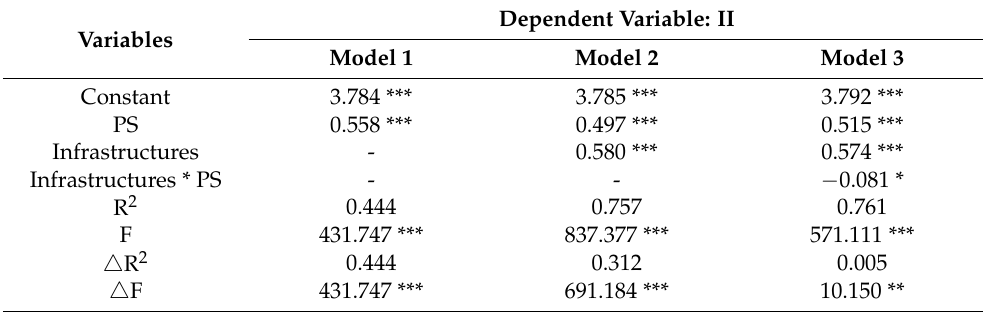
Table 8. Hierarchical regression analysis of relationship between infrastructures, PS, and